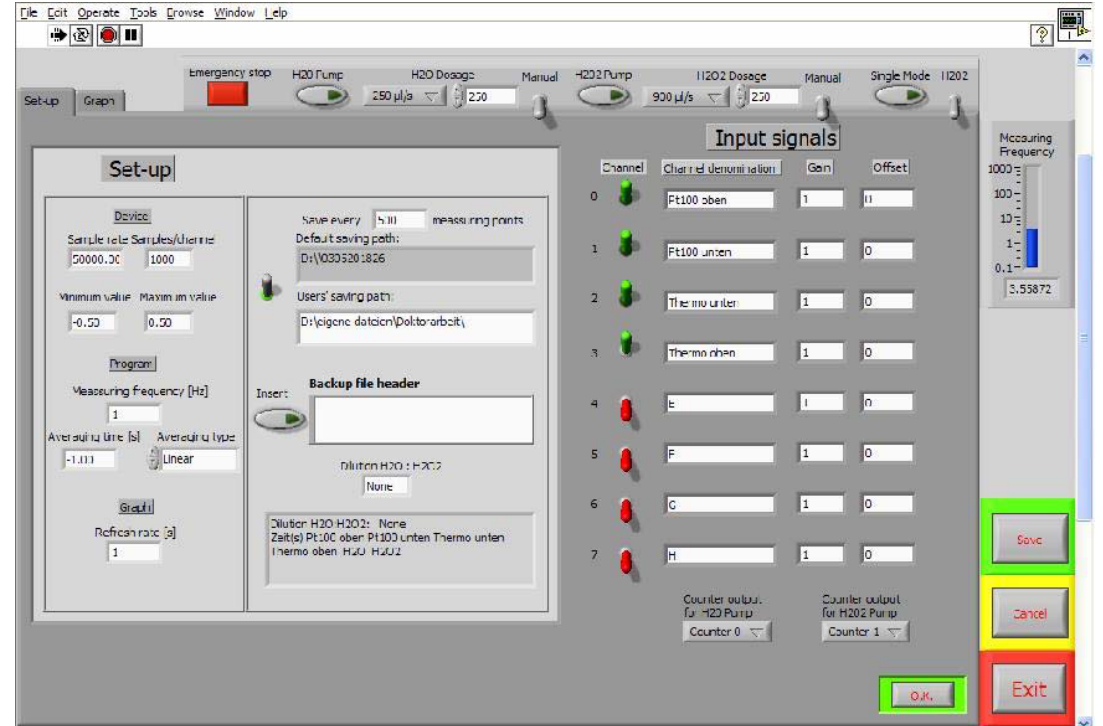
Figure 2. User interface of the developed